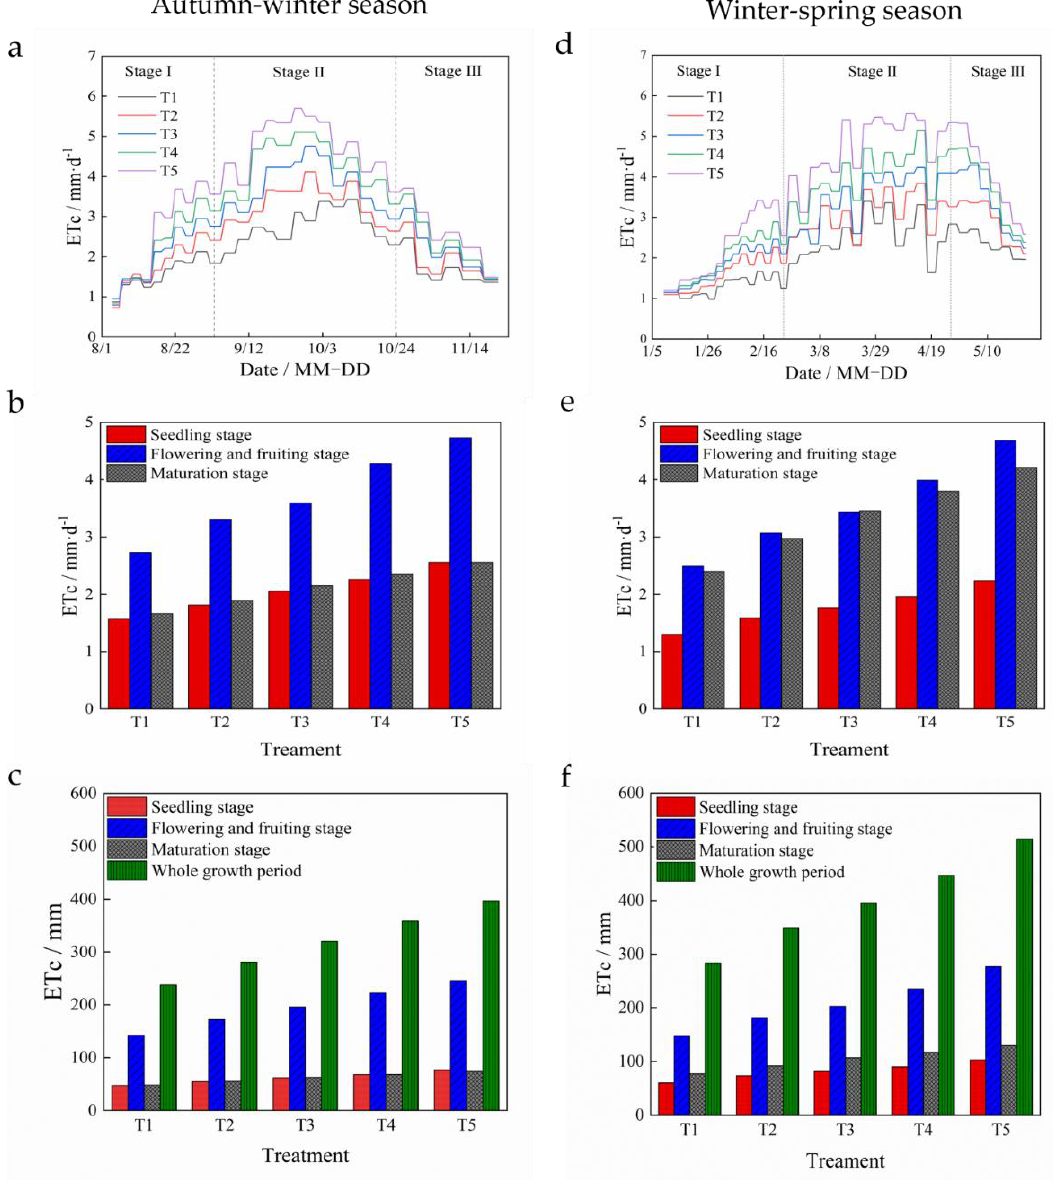
Figure 5. Variation in the tomato’s daily ET c for each treatment during the whole growth period ( a , d ). Average daily ET c ( b , e ) and, cumulative ET c ( c , f ) for tomatoes under the different treatments during three growth periods. Stages I, II and III in figures represent seedling, flowering and fruiting, and maturation stage, respectively.